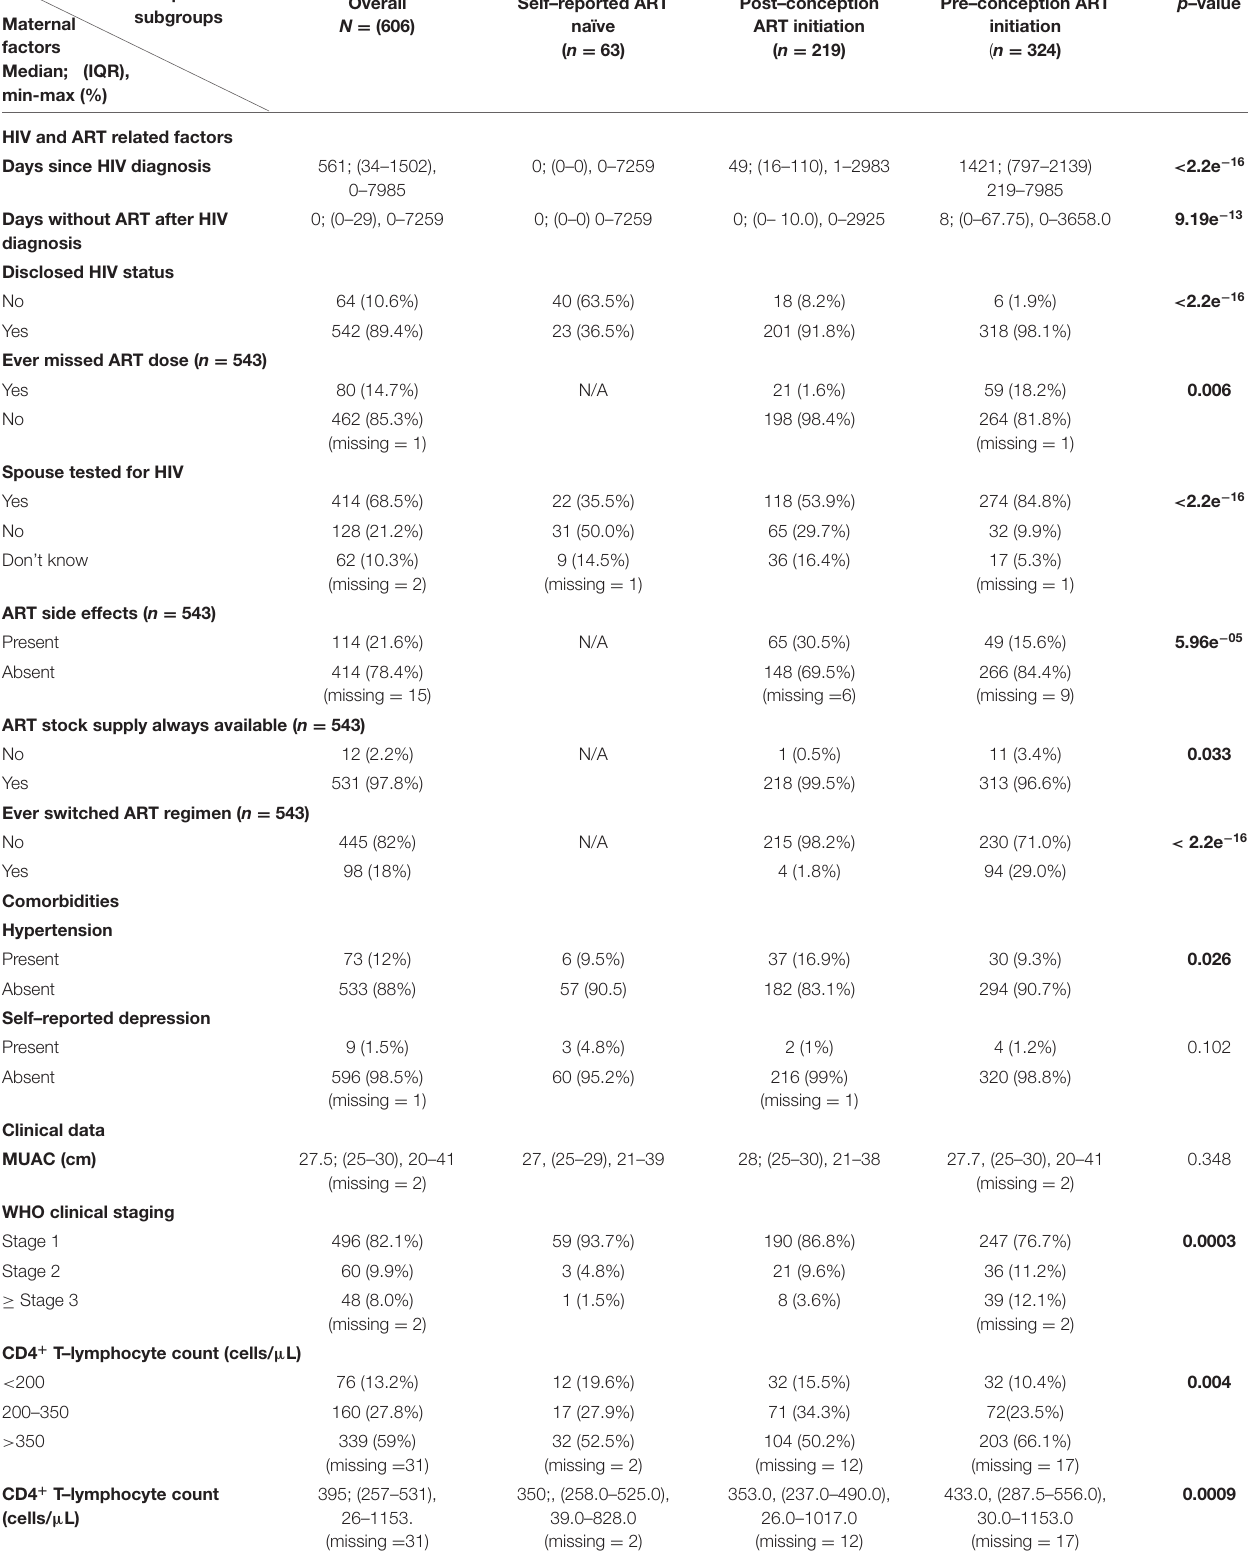
TABLE 2 | HIV and ART related parameters of the study